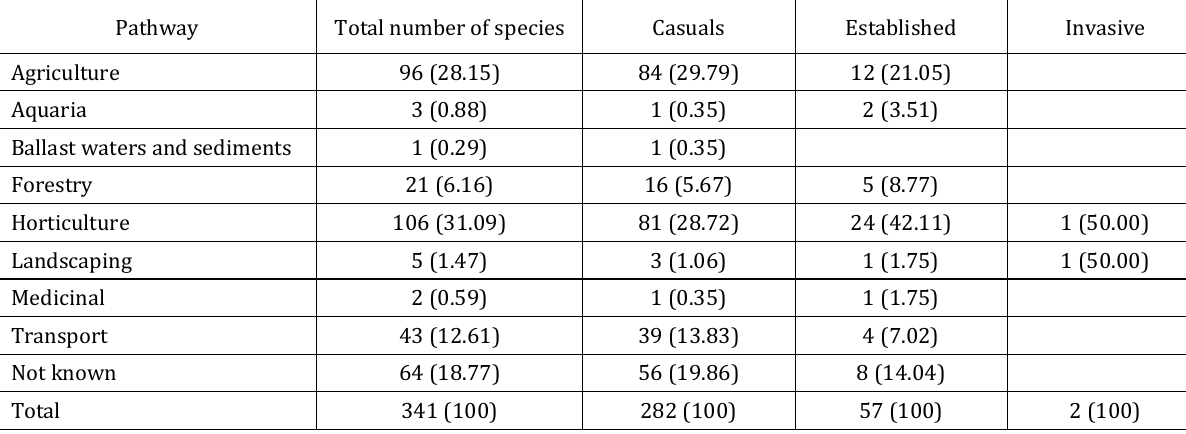
Table 2. Pathways used by non-native plant species in Iceland. Totals and percents (in brackets) were given for each pathway and for each group of non-native species: casuals, established and invasive taxa Pathway Total number of